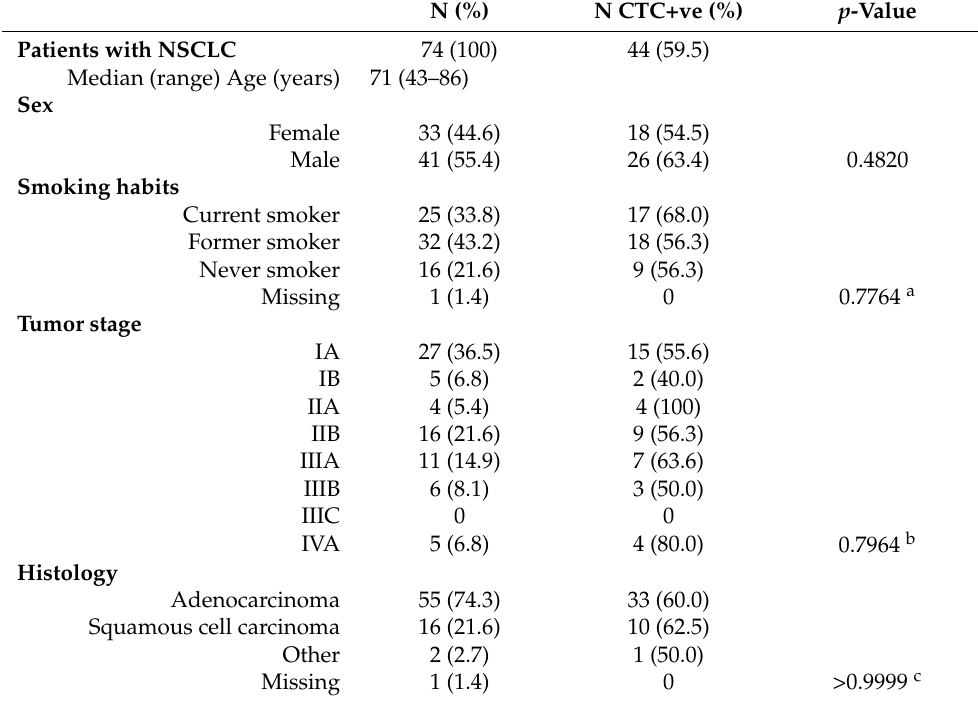
Table 1. Circulating tumor cell (CTC) detection rate and cohorts’